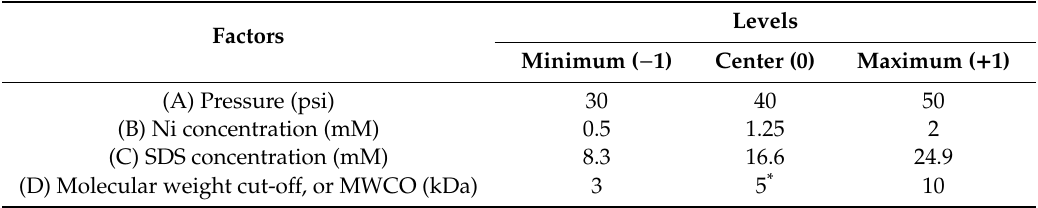
Table 3. Factors and levels set by Box–Behnken design